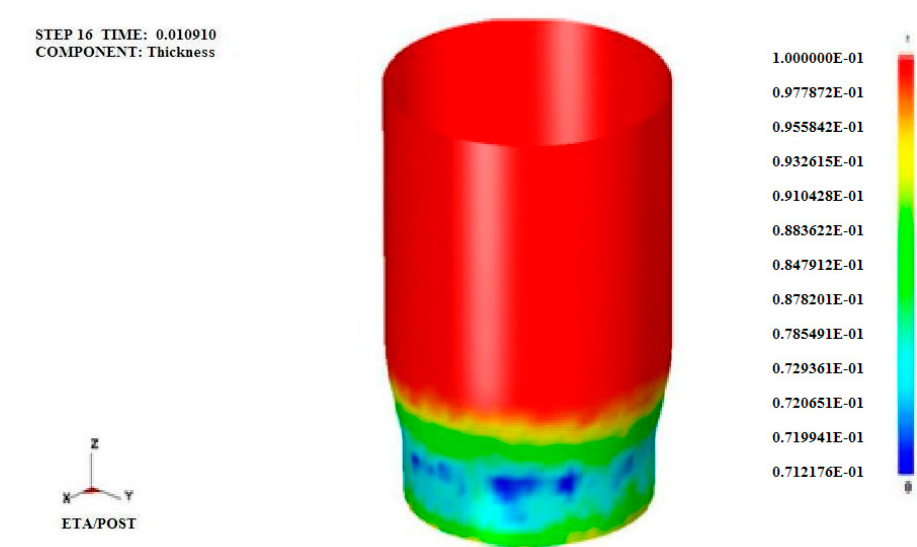
Figure 13. Wall thickness after the first draw s n = 0.0752 mm.